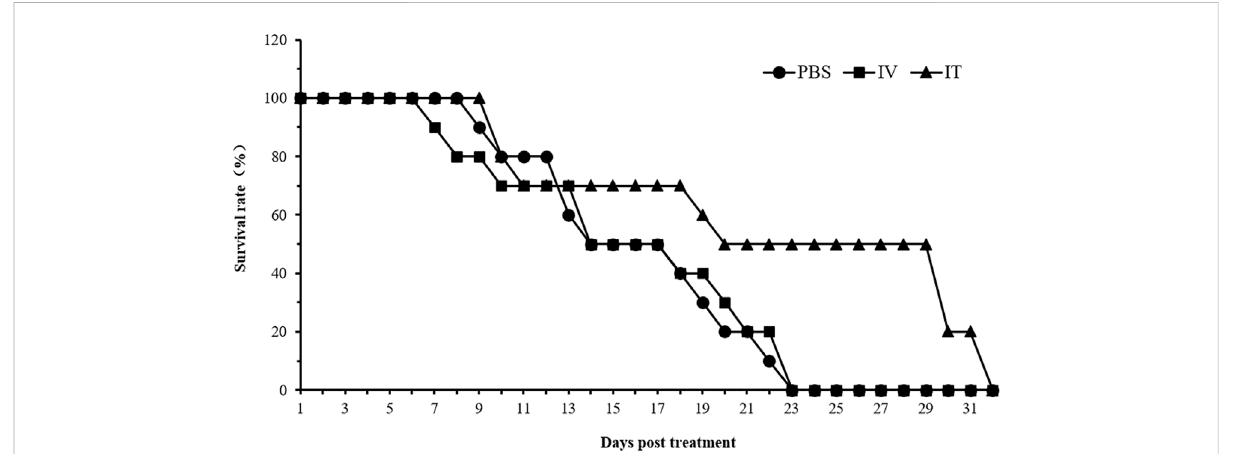
FIGURE 5 The effect of HN_xs01 on mouse survival. C57BL/6 mice were administered with strain HN_xs01 intravenously (5 × 10 7 CFU/100 μ l) and intratumorally(1×10 8 CFU/100 μ l)for32 days,respectively.ThecontrolgroupreceivedanequivalentvolumeofPBS.Therewere10micepergroup, and the mice were monitored for 32 days. IV: intravenous injection, IT: intratumoral